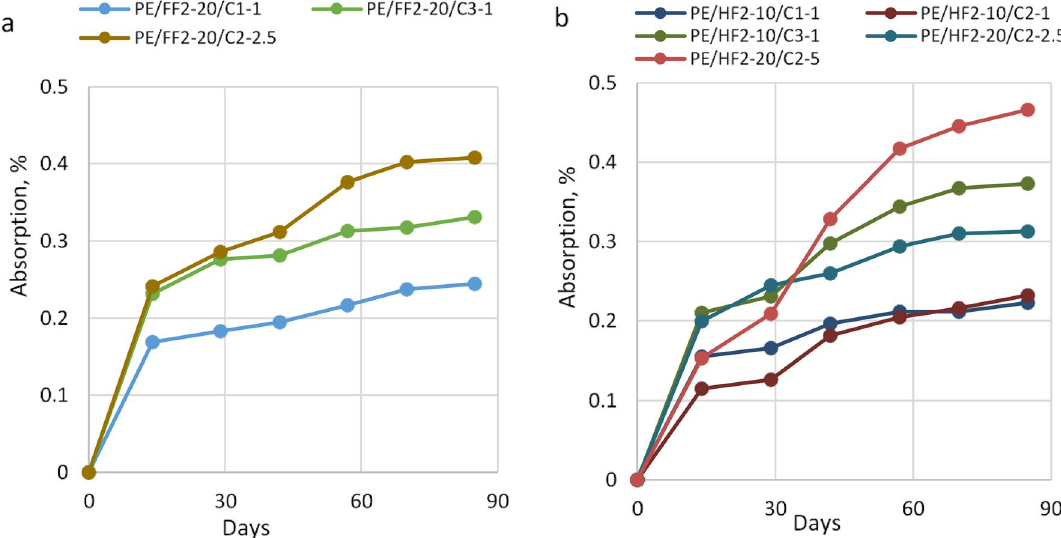
Figure 3. Moisture sorption bio-PE composites with flax or hemp fibers, at 30%